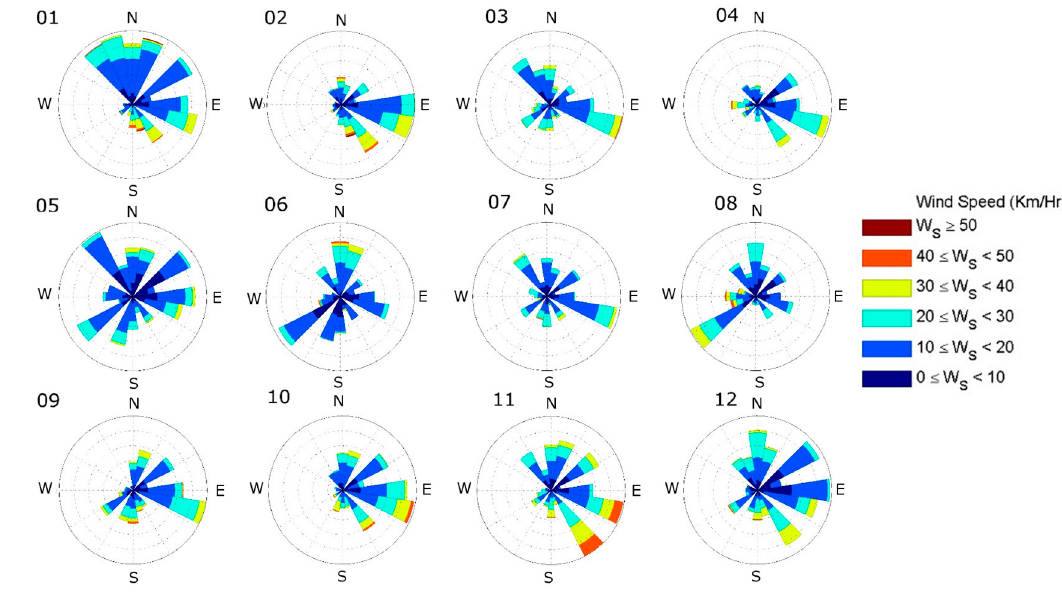
Figure 11. Wind rose (winds speed and direction average) for each month of 2014 at the National Meteorological Service station located at Aeroparque airport (2003–2013). Source: National Meteorological Service